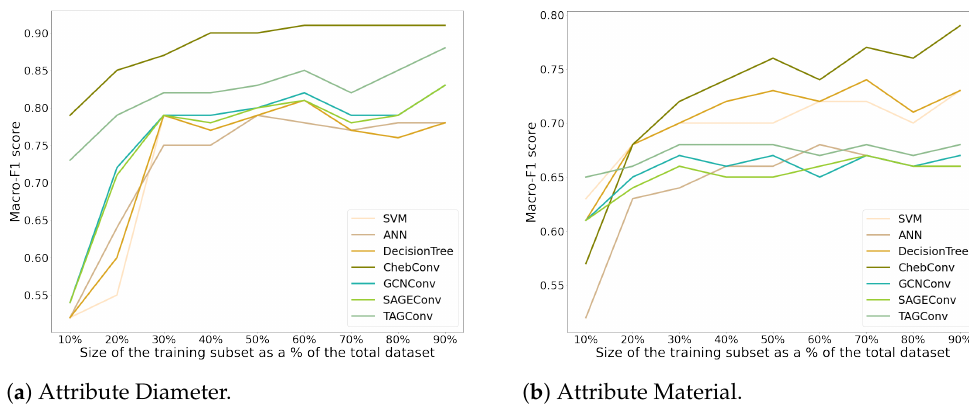
Figure 9. Models performances evolution (F1 score) while decreasing the amount of missing data for the configuration 2 of the Montpellier